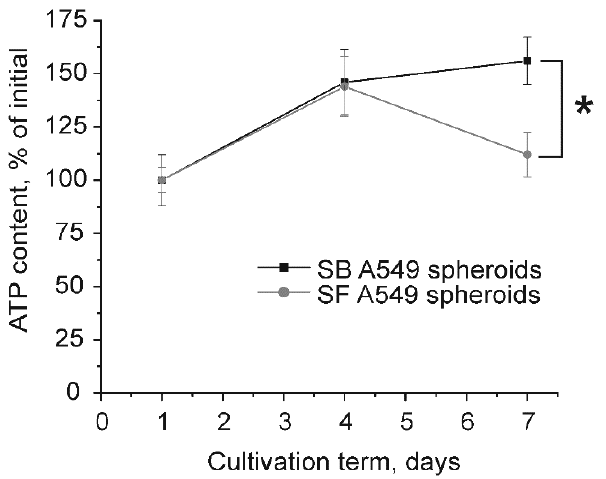
Figure 2. Measurement of total ATP amount in SF and SB A549 spheroids at different time points. ATP content correlates with viable cell number and reflects spheroid growth rate. Data are shown as means ± SD ( n = 4–5). * p < 0.05 (Mann–Whitney U test).